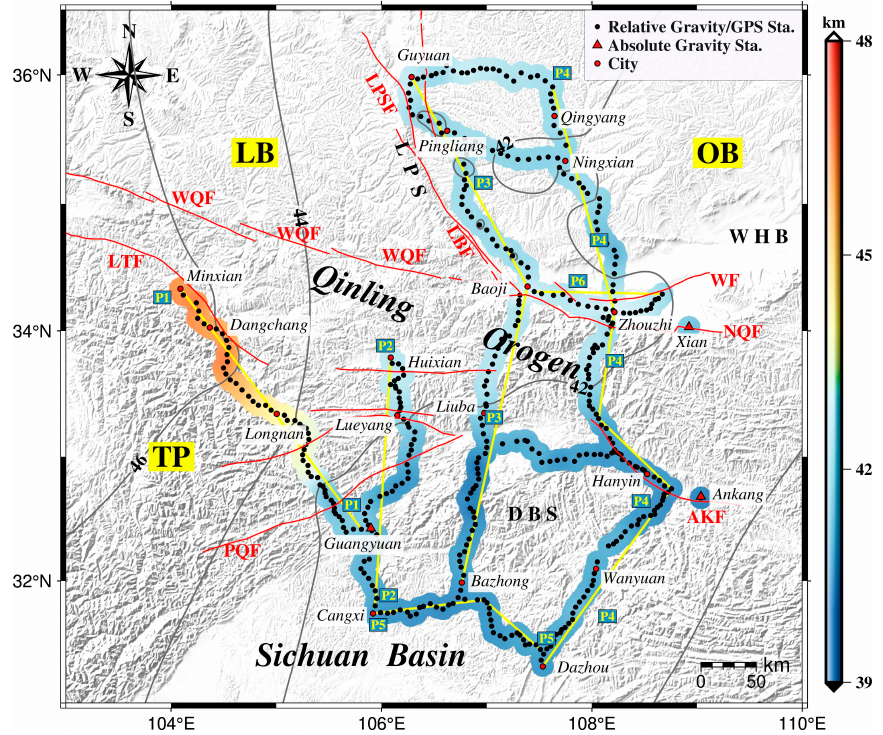
Figure 6. The Moho depth map in the Qinling area. Abbreviations are the same as those used in Figure 1.